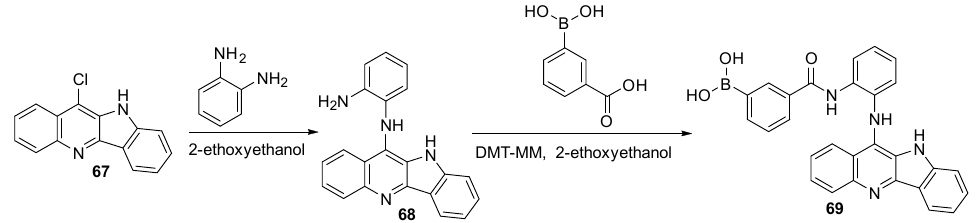
Scheme 16. Synthesis of quindoline derivative 69 as anti-influenza A